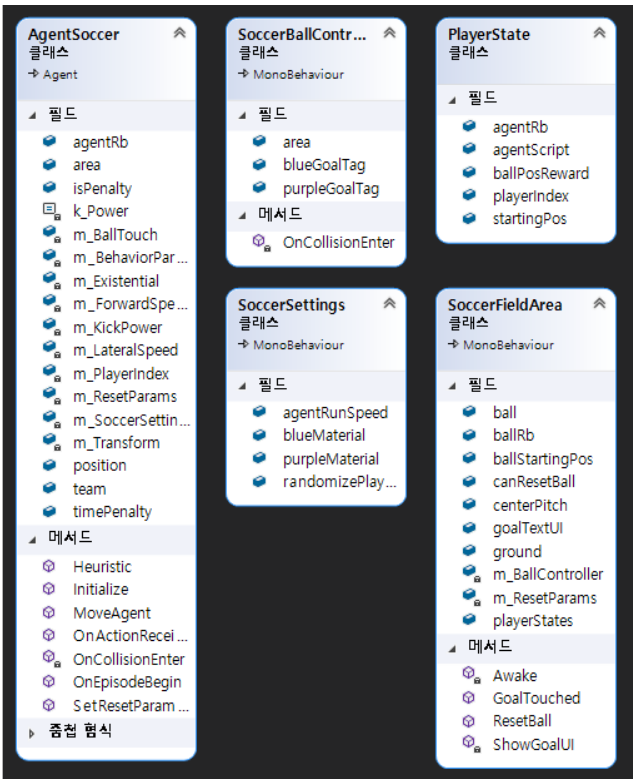
Figure 8. Futsal game-class diagram.